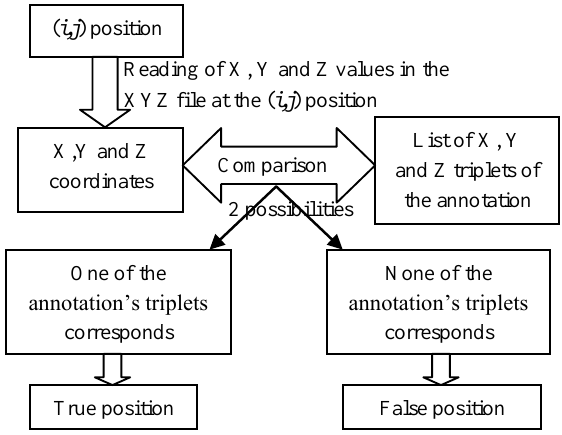
Figure 11: Research of true position and false position on the image Starting from true and false positions for a XYZ file, a mask is then constructed, where true positions are represented by white pixels and false positions by black pixels (Figure 12).